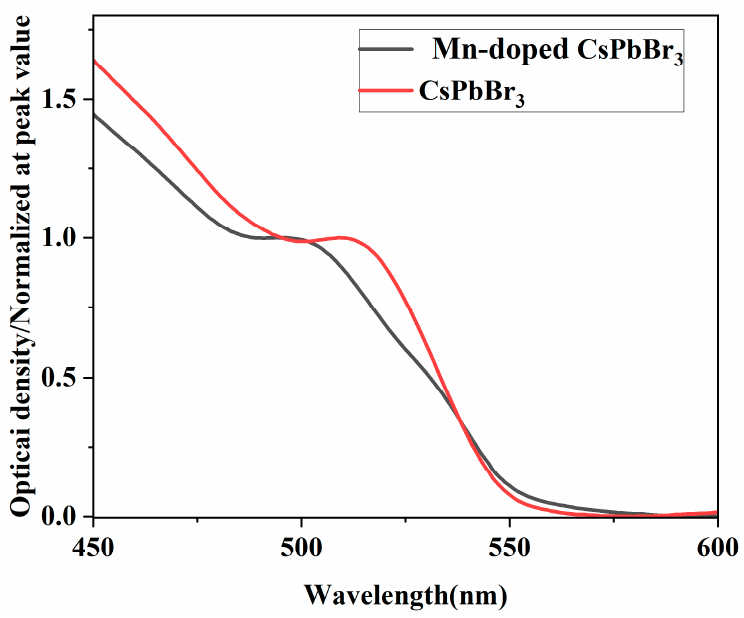
Figure 2. The steady-state absorption spectra of CsPbBr 3 and Mn-doped CsPbBr 3.